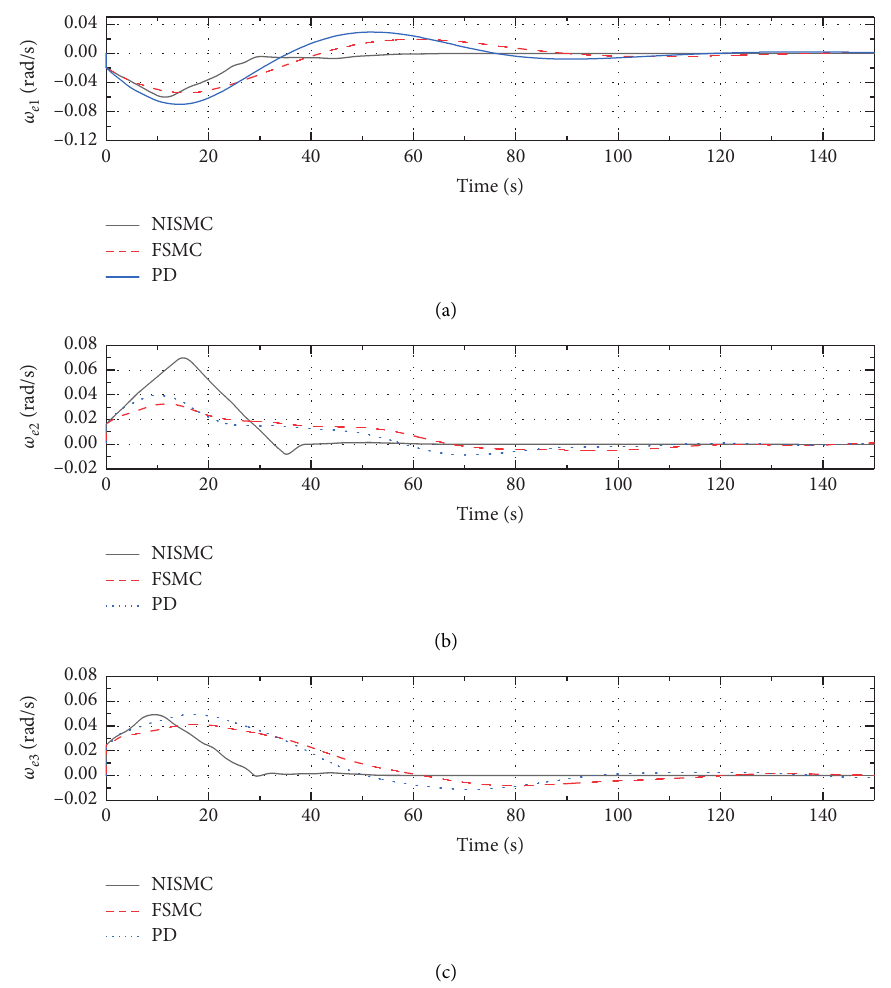
Figure 9: Comparison of errors of attitude angular velocity of